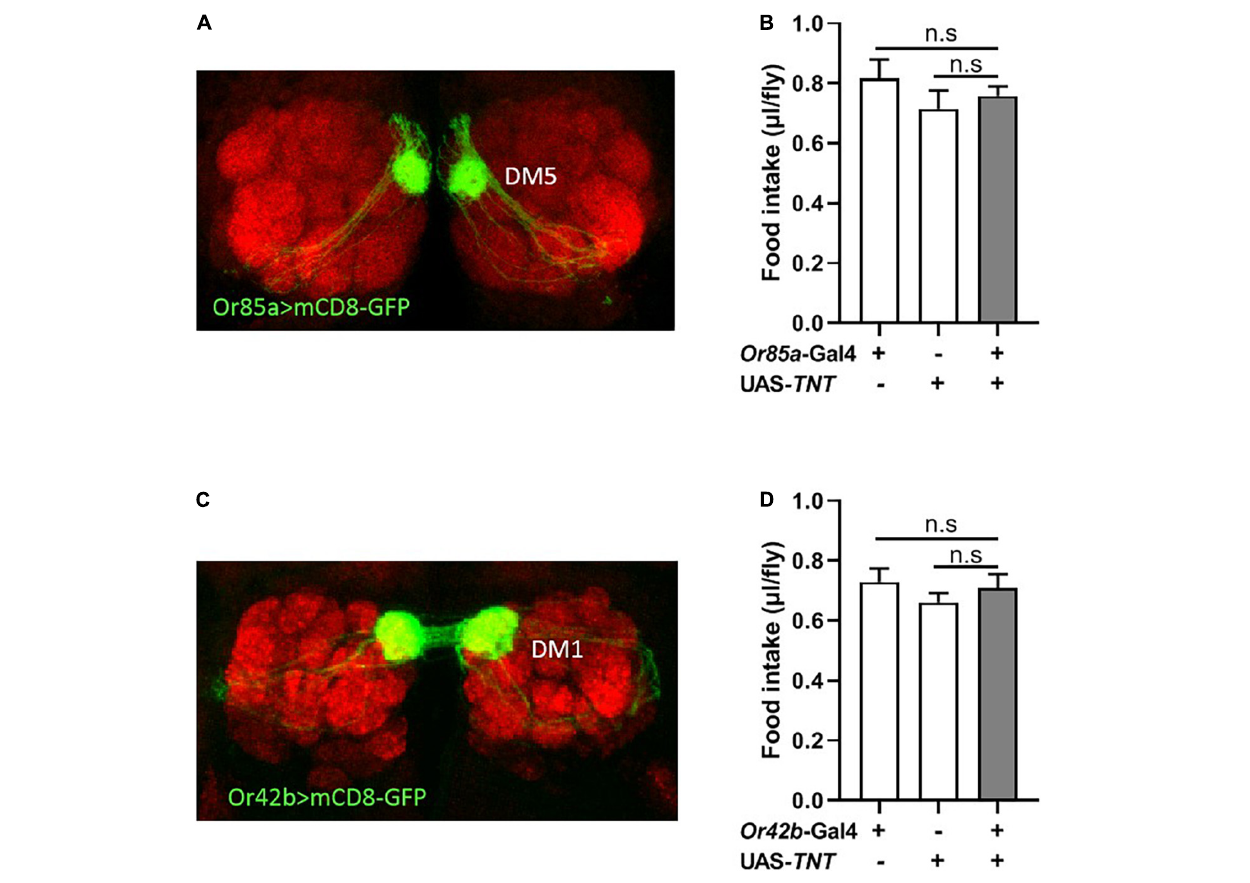
FIGURE 4 | Or85a OSNs regulates food consumption. (A) Expression of Or85a OSNs in DM5 of antennal lobe. Or85a -GAL4 drives UAS-mCD8-GFP expression (Green). (B) The food consumption was not affect after expression TNT in Or85a OSNs ( n = 21). (C) Expression of Or42b OSNs in DM1 of antennal lobe. Or42b -GAL4 drives UAS-mCD8-GFP expression (Green). (D) No effect on food intake after expression TNT in Or42b OSNs ( n = 15). One-way ANOVA followed by Dunnett’s post-hoc test were used to analyze the